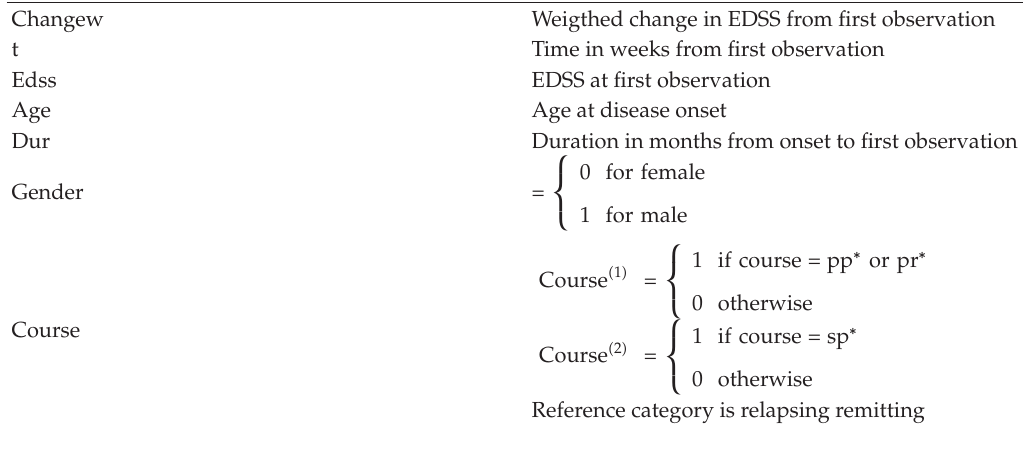
Table 10: Description of the covariates included in the analysis of SLCMSR data set (cid:3) ∗ pp: primary progressive; pr: progressive relapsing; sp: secondary progressive (cid:4) .